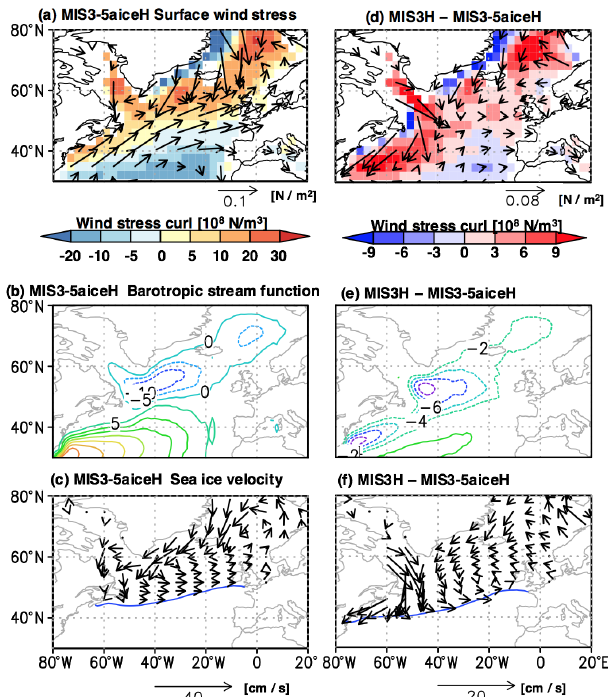
Figure 10. Comparison of surface wind and wind-driven oceanic components between MIS3H and MIS3–5aiceH. Annual mean cli- matology values of (a, d) surface wind stress, (b, e) barotropic streamfunction (m 2 s − 1 ) and (c, f) sea ice velocity (cms − 1 ) are shown. In panels (a) , (b) and (c) , results from MIS3–5aiceH are shown. In panels (d) , (e) and (f) , the differences between MIS3H and MIS3–5aiceH are shown. Blue contour lines in panels (c) and (f) show sea ice edges (15% concentration) of MIS3–5aiceH and MIS3H, respectively. The average over the last 100 years of hosing (years 401–500) is